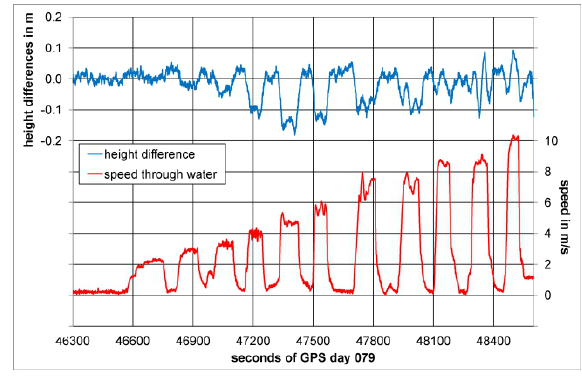
Figure 14. Speed-depending height variation of the ARP aboard the escort craft. Used data points and control points of least squares thin-plate spline adjustment and resulting thin- plate spline